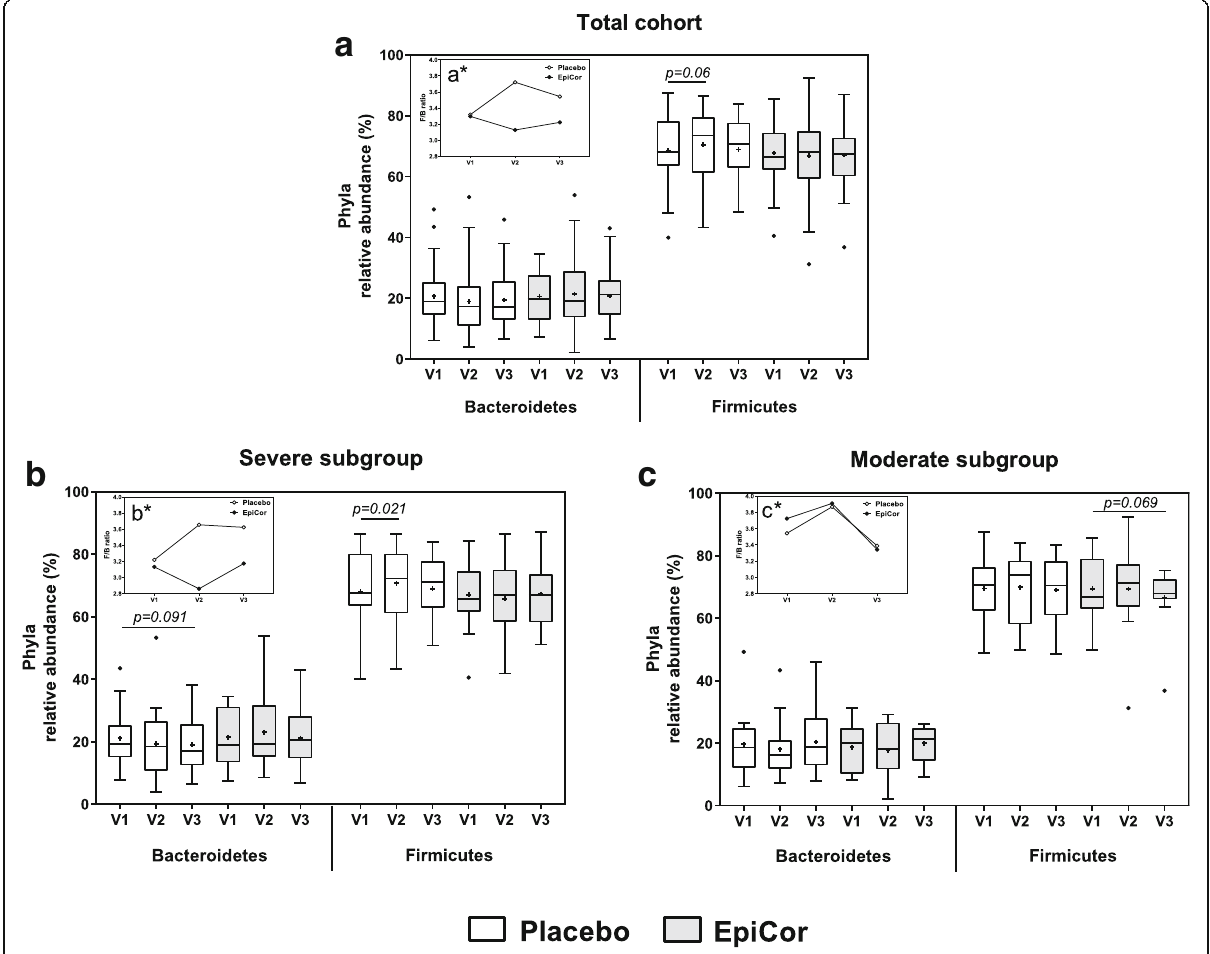
Fig. 6 Bacteroidetes and Firmicutes relative abundances within the total cohort ( a ) and the two subgroups, severe ( b ) and moderate ( c ) that have been treated either with placebo or EpiCor. Each box represents median (50th percentile) and interquartile range (25th and 75th percentiles). The symbol (+) represents the mean. The outliers are indicated as dots (Tukey method). Significant ( p < 0.05) and nearly significant ( p < 0.1) p -values are also indicated within the boxplots (two-way repeated measures ANOVA with Dunnett ’ s multiple comparison ’ s test against V1). The inner plots (a*, b* and c*) correspond to the calculated Firmicutes/Bacteroidetes (F/B) ratio at each visit within the two treatment groups. Legend: V1, V2 and V3 correspond to visit 1 (baseline), visit 2 (3-weeks after treatment) and visit 3 (6-weeks after treatment),